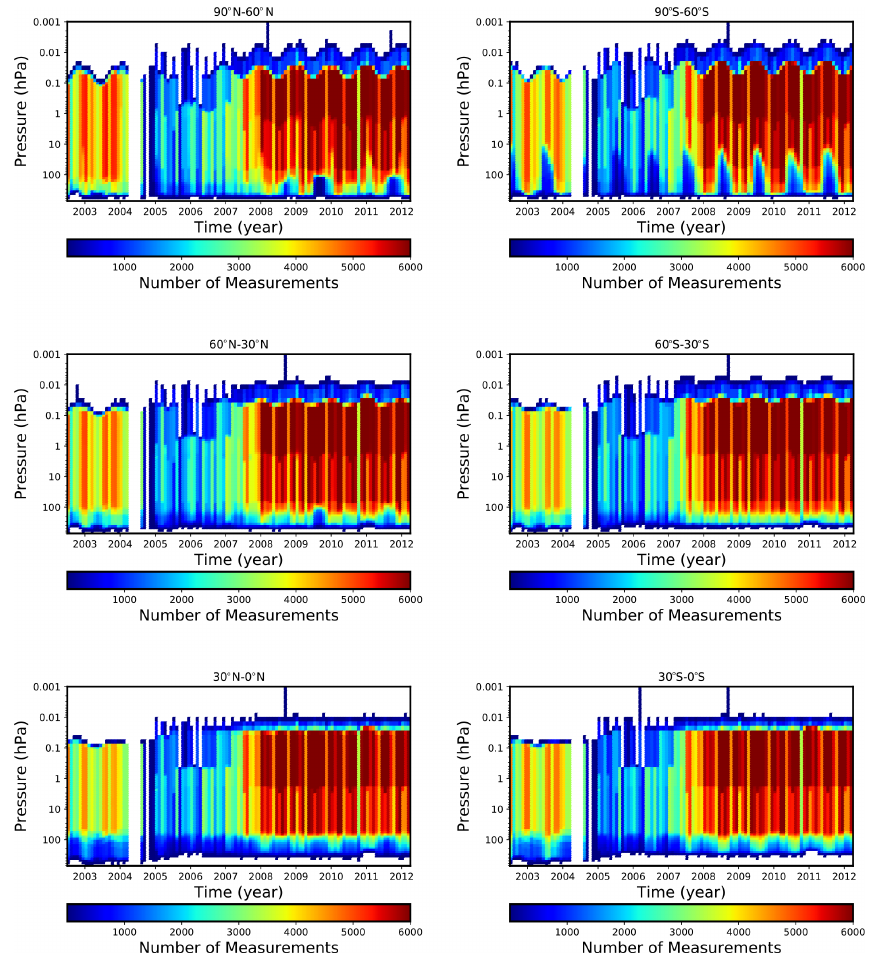
Figure 9. Number of temperature data present in the MIPAS level2-v8 database for each month and pressure bin, reported in six latitude bands. From top to bottom (left to right): polar north (90–60 ◦ N), midlatitude north (60–30 ◦ N), equatorial north (30–0 ◦ N), equatorial south (0–30 ◦ S), midlatitude south (30–60 ◦ S), and polar south (60–90 ◦